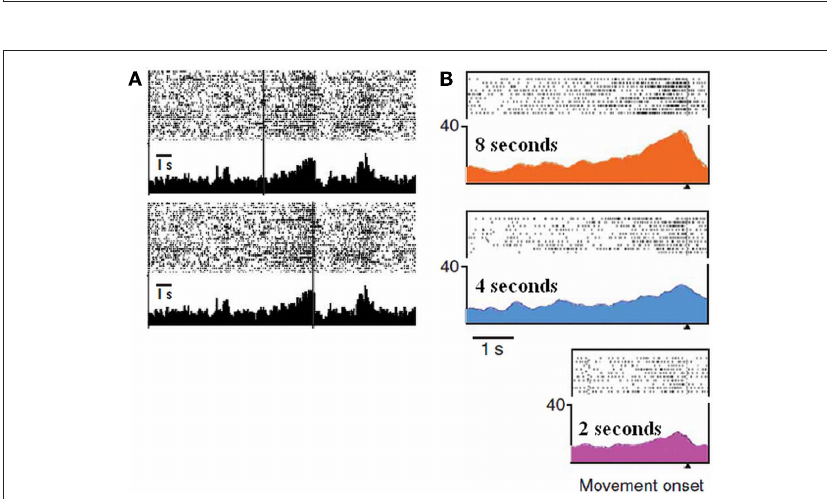
Figure 3 | Single unit activities as a function of elapsed time in a time estimation task (A) (adapted from Akkal et al., 2004) and in a production task (B) (adapted from Mita et al., 2009) . (A) Raster displays and peri-event histograms: The figure represents an example of pre-SMA cells showing build-up neuronal activity as time elapses. The vertical bars indicate the onset (top) and the end (bottom) of the interval. Note that this pattern only occurs when the end of the interval can be predicted, that is when this interval is fixed. (B) Raster displays and spike-density functions: The figure represents an example of pre-SMA cells showing graded neuronal activity that depended on the time intervals to be produced: highest during a 8-s interval, moderate during a 4-s interval, and lowest during a 2-s interval. The displays are aligned according to the end of the